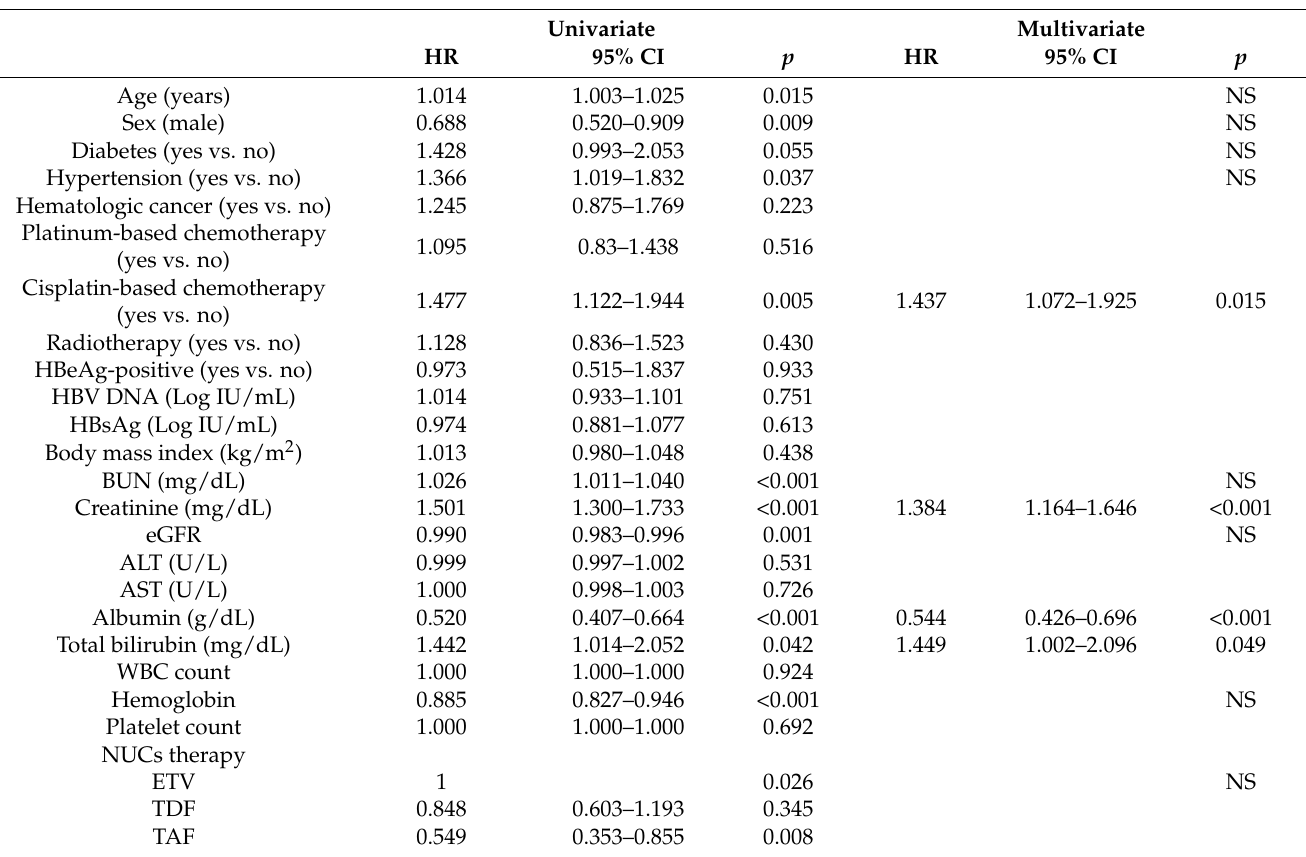
Table 3. Univariate and multivariate analyses of factors associated with acute kidney injury during antiviral prophylaxis.